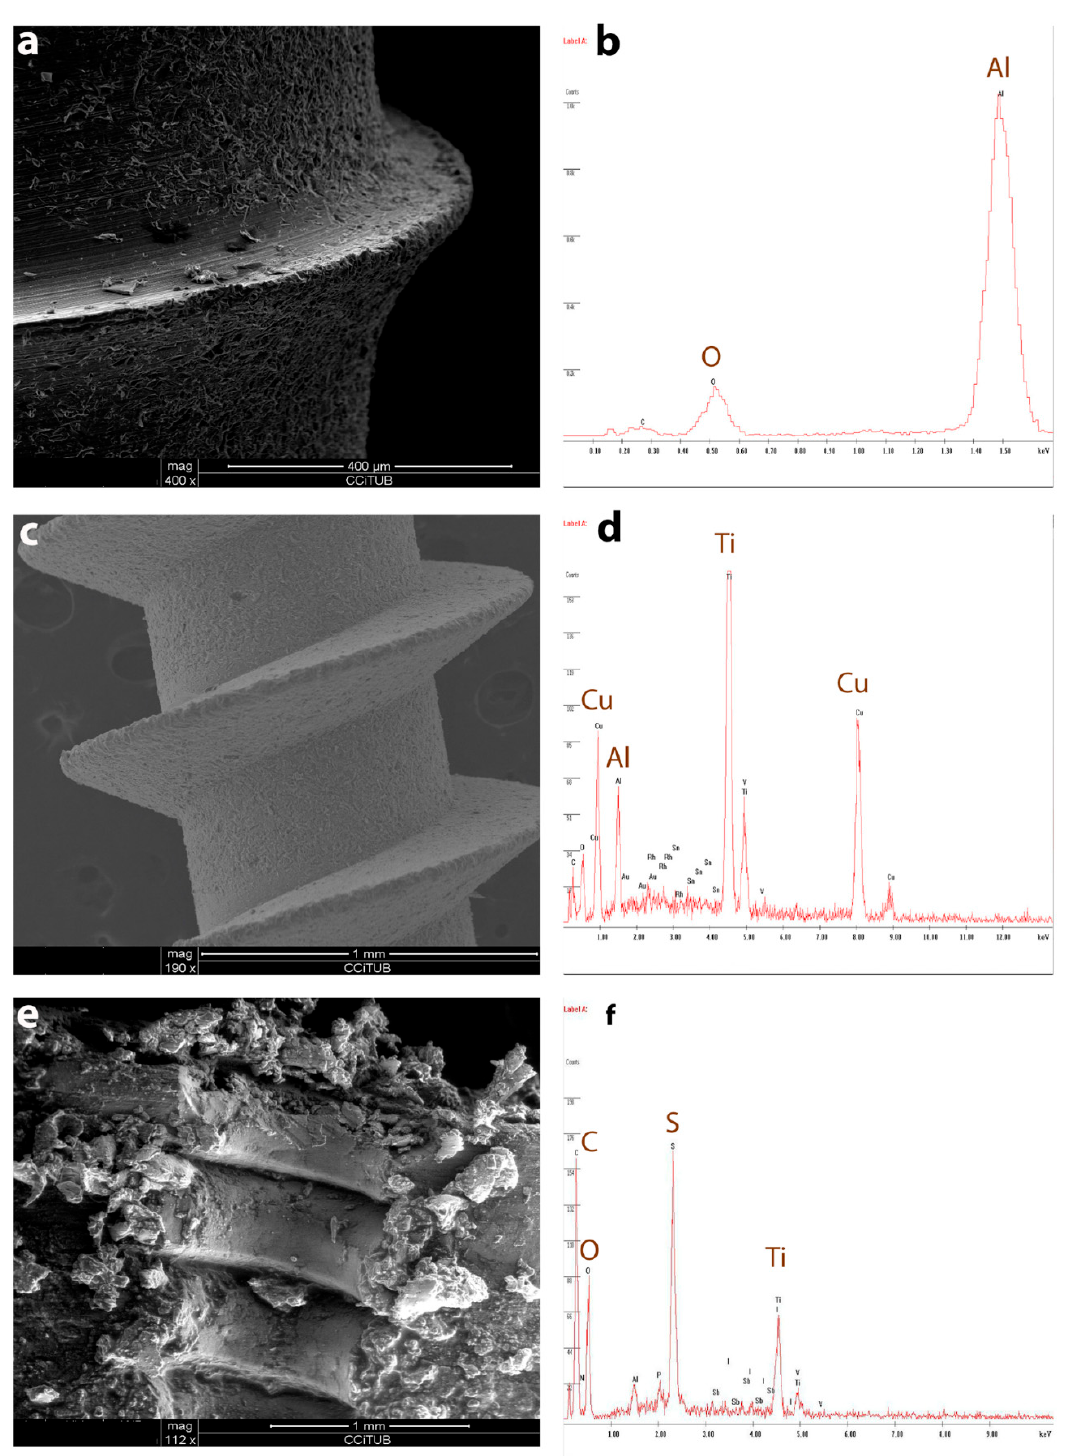
Figure 4. ( a , b ): Sandblasted OMI: ( a ). SEM image of OMI surface, ( b ). Energy-Dispersive X-Ray Analysis (EDX) identifica- Figure 4. ( a ) and ( b ) : Sandblasted OMI: ( a ) . SEM image of OMI surface, ( b ) . Energy-Dispersive X-Ray Analysis (EDX) identification of aluminum oxide on the sandblasted OMI. ( c ) and ( d ) : Sandblasting and anodic oxidation (SBAO) mini- tion of aluminum oxide on the sandblasted OMI. ( c , d ): Sandblasting and anodic oxidation (SBAO) mini-implant: ( c ). SEM implant: c. SEM image of OMI surface, ( d ) . EDX identification of aluminum oxide and copper molecules on the SBAO image of OMI surface, ( d ). EDX identification of aluminum oxide and copper molecules on the SBAO mini-implant. ( e , f ): mini-implant. ( e ) and ( f ) : Cow bone section (cortical and medullar) after OMI removal: ( e ) . SEM image of bone surface, Cow bone section (cortical and medullar) after OMI removal: ( e ). SEM image of bone surface, ( f ). EDX identification of ( f ) . EDX identification of titanium alloy and aluminum oxide, copper, and sulfur particles on the bone surface. titanium alloy and aluminum oxide, copper, and sulfur particles on the bone SBAO also left OMIs surfaces with similar but smaller irregularities (Figure 4c).